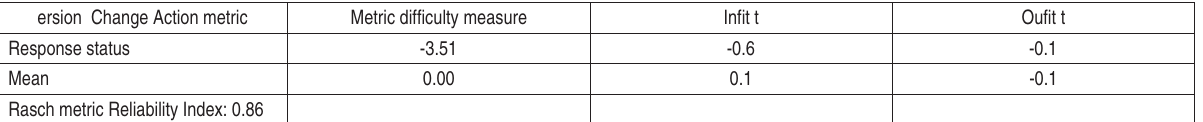
Table 2 (cont.). “CDP” and capitalization should be consistent Difficulty Hierarchy of Climate Change Ac-